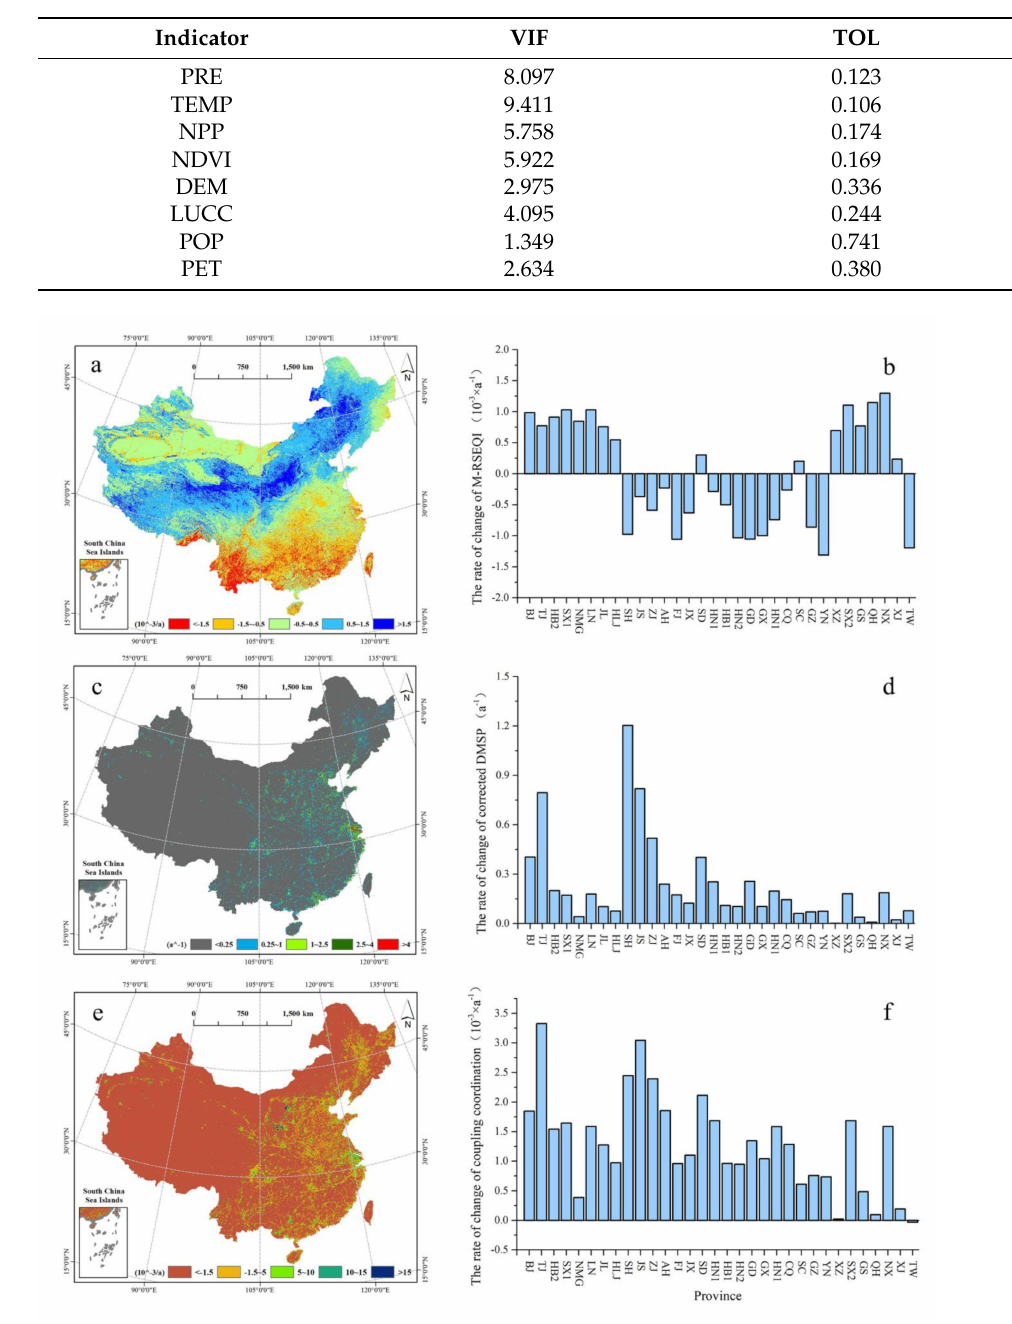
Figure 4. The change trend distribution of M-RSEQI ( a ), DMSP ( c ), and CCD ( e ) in China from 2000 to 2013 and the average trend value of M-RSEQI ( b ), DMSP ( d ), and CCD ( f ) for each